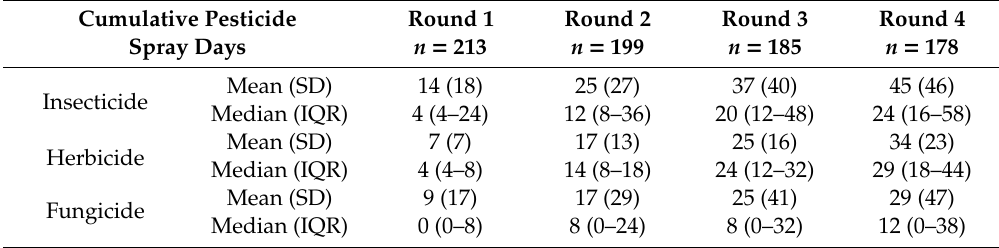
Table 4. Self-reported cumulative days of spraying insecticides, herbicides, or fungicides for each consecutive round among conventional farmers.